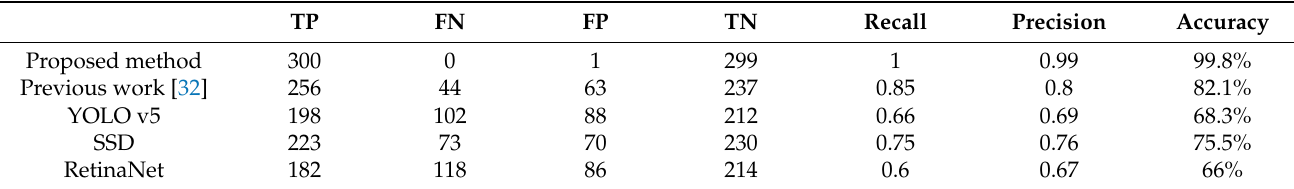
Figure 13. Dotted defect model training results for convolution layers. ( a ) Feature map of the first convolution layer; ( b ) feature map of the second convolution layer; and ( c ) feature map of the third convolution layer. Table 2. Quantitative comparison results (nonlinear defect detection).